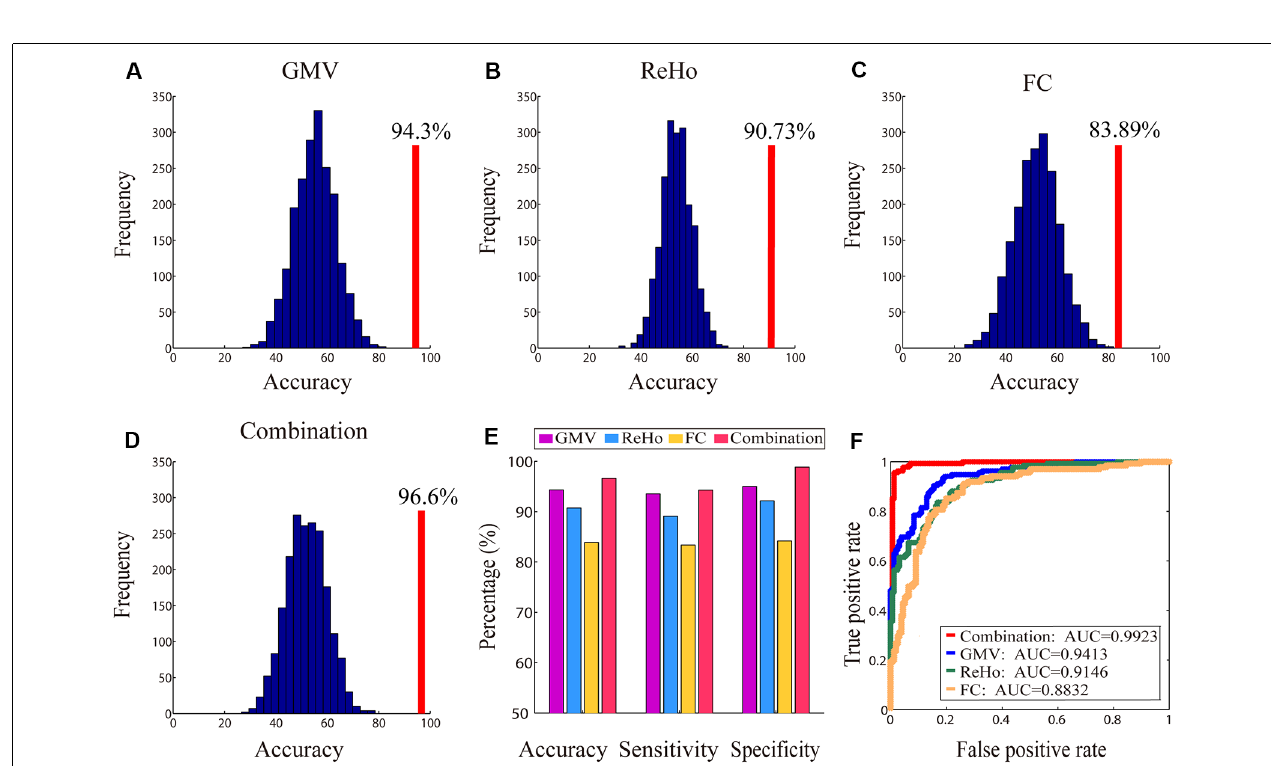
FIGURE 6 | The accuracies of the classification between genders along with their corresponding null distributions for each measure (Panels A–C ) and the combination of all measures (Panel D ), the bar plot of all classification accuracies, sensitivity and specificity (Panel E ) and the receiver operating characteristic (ROC) curves and corresponding area under the curves (AUCs; Panel F ). In Panels (A–D) , the classification accuracies are indicated by red vertical lines and corresponding null distributions (obtained from 2,000 permutations) are indicated by blue bell-shaped distributions centered around chance level accuracy of 50%. All accuracies were statistically significant ( p <